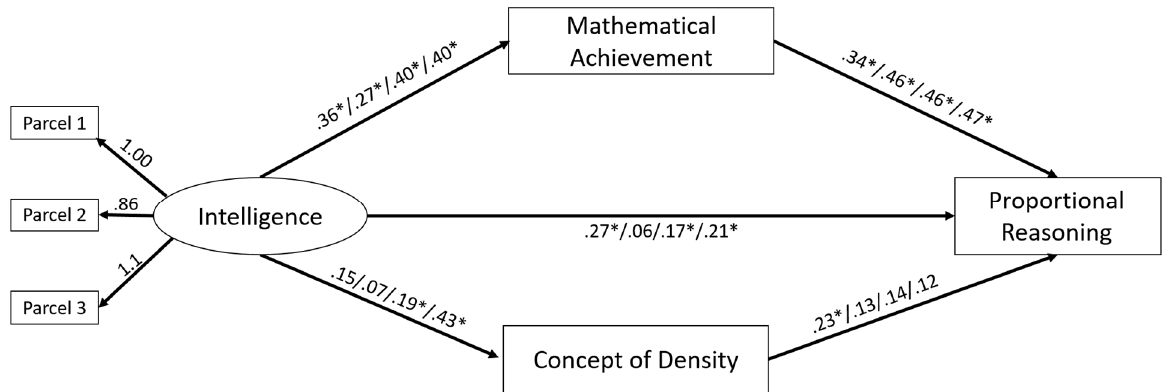
Figure 6. Mediation model for Study 2. Intelligence is modeled as a latent construct reflected in three item parcels. Values on the left arrows show factor loadings on these parcels. The other values depict standardized estimates per group separated by forward slashes ( noF&S/density ; noF&S/speed ; F&S/density ; F&S/speed ). Asterisks indicate significance at p < 0.05.